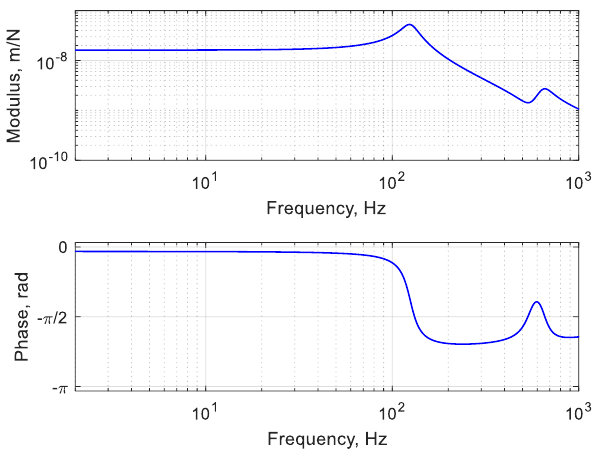
Figure 4. Track direct vertical receptance.